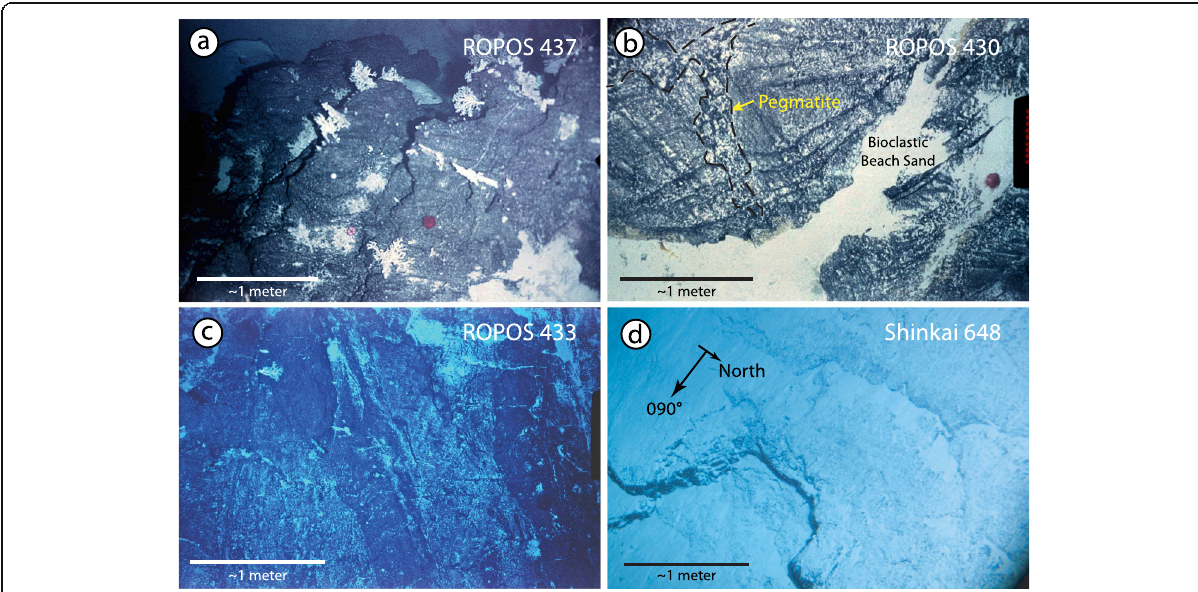
Fig. 27 Seafloor images from the ROPOS ROV and Shinkai 6500 submersible. Panels a to c are all vertical ROPOS images of the seafloor on the wave-cut platform. The outcrops are all pitted due to preferential erosion of plagioclase and olivine, with white bioclastic sand filling the pits between pyroxene grains. a Dive 437 image showing heavily weathered and pitted outcrop of flat-lying amphibolite mylonite. b Dive 430 image showing a pegmatite crosscutting a relatively undeformed gabbro enclave with two sub-orthogonal amphibole vein sets on weathered wave-cut outcrops emerging from indurated bioclastic beach sand. c Dive 433 image of sub-parallel dikes crosscutting intercalated gabbros in a relatively undeformed gabbro enclave on weathered sub-horizontal outcrop. d Shinkai 6500 Dive 648 showing the shingle-structured, slickensided and down-dip slickenlined, east-dipping normal fault surface on the lower normal fault on the eastern flank of Atlantis